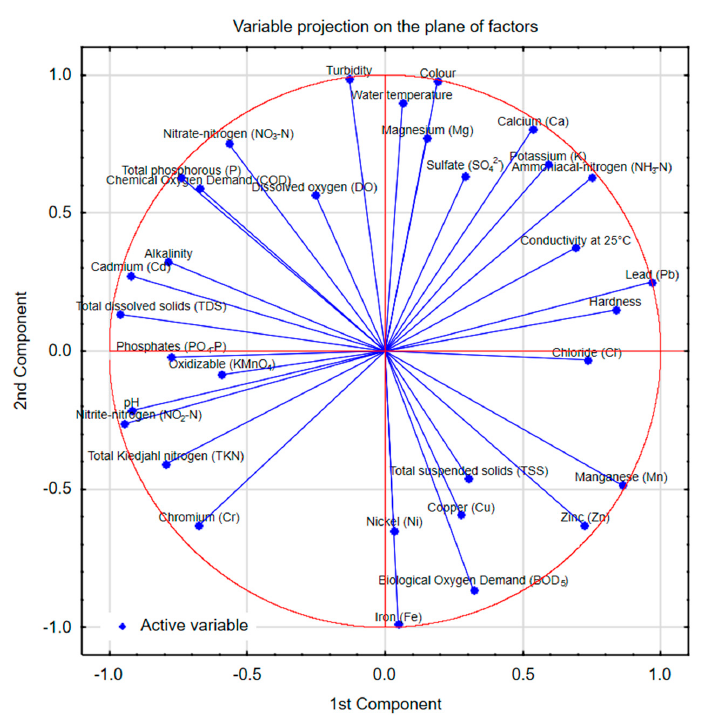
Figure 12. Projection of variables on component 1 and component 2 plane. Water 2019 , 11 , x FOR PEER REVIEW